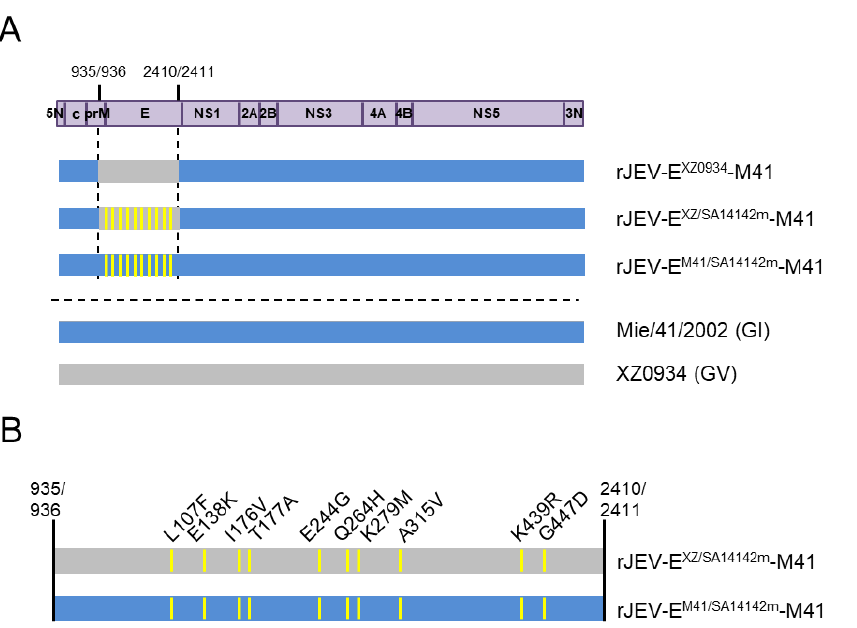
Figure 1. ( A ) Schematic representation of the genomic structure of recombinant JEVs used in this study. Regions derived from GI Mie/41/2002 and GV XZ0934 strains are shown in blue and gray, respectively. Yellow lines indicate point mutation sites. Numbers: nucleotide positions in the Mie/41/2002 genome. ( B ) Enlargement of the E regions of rJEV-E XZ/SA14142m -M41 and rJEV- E M41/SA14142m -M41 genomes in ( A ). Ten amino acid substitution sites are